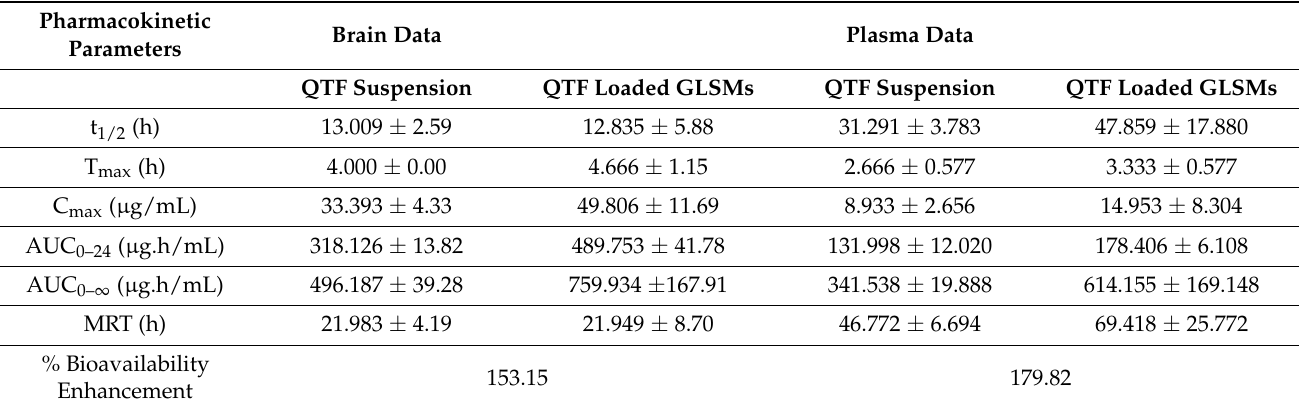
Table 6. Pharmacokinetic Parameters of QTF in the brain after oral administration of QTF suspension and QTF Loaded